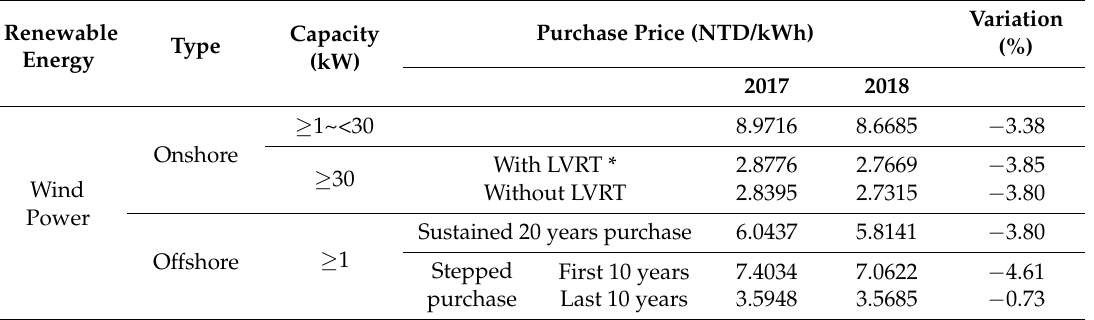
Table 5. Wind power purchase price in Taiwan